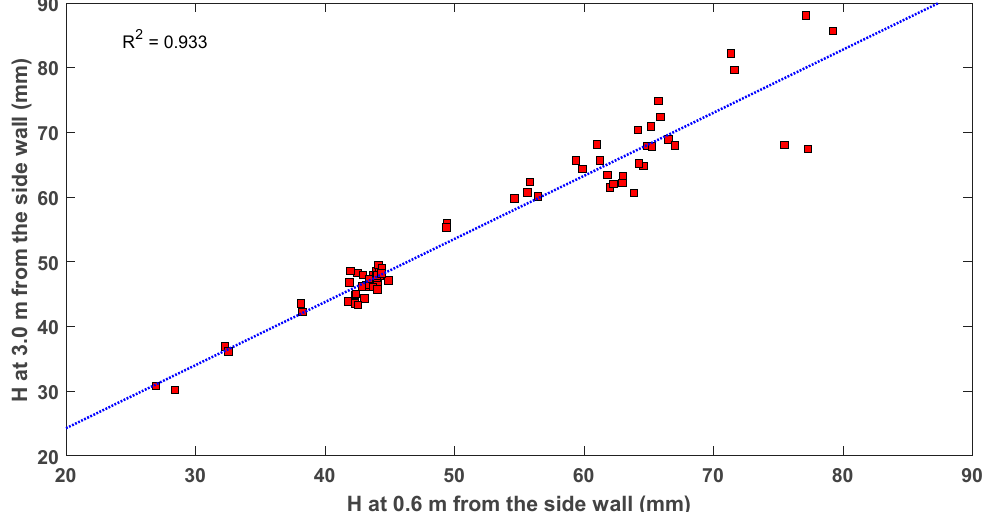
Figure 4. Wave height data measured at 5.8 m away from the wavemaker and at different distances from the basin side wall.